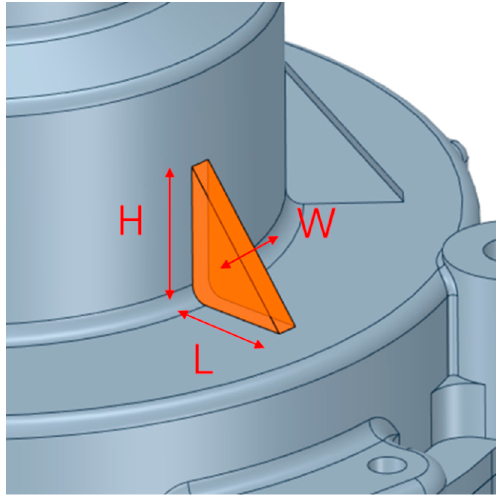
Figure 11. Parameters of the rib design.